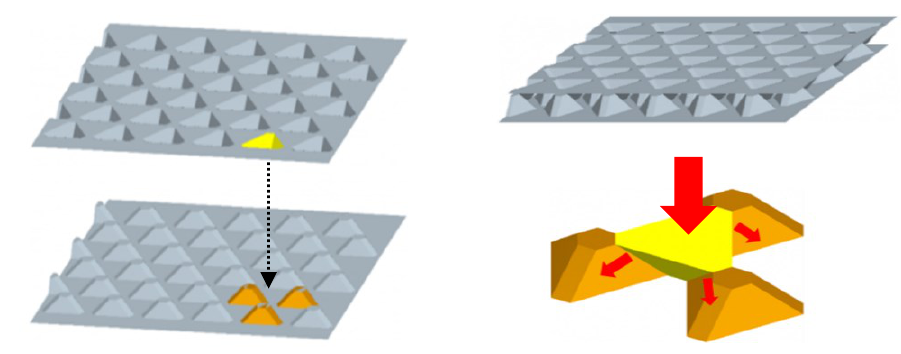
Figure 2. The double truss core panel can diffuse the load through the diagonal surface of the truss core.